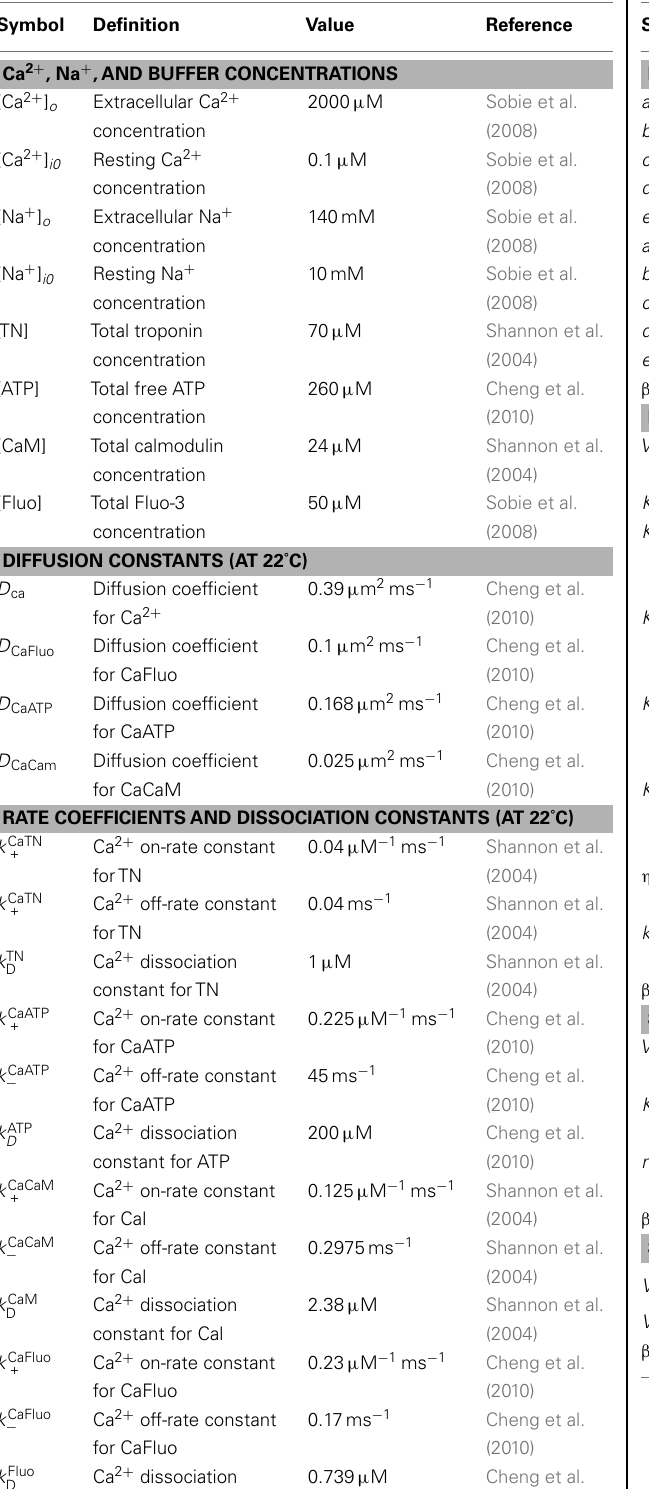
TableA2 | Calcium and buffer reaction-diffusion parameters. TableA3 | Membrane calcium fluxes